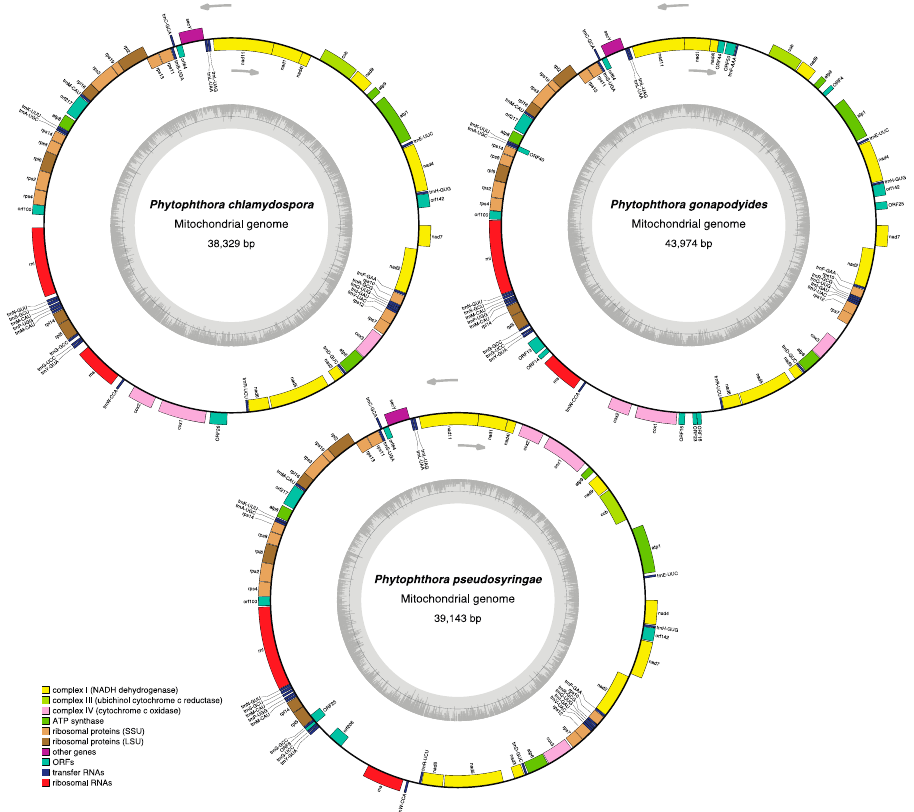
Figure 3. Circular maps of the mitochondrial genomes of Ph. chlamydospora , Ph. gonapodyides and Ph. pseudosyringae . The inner ring shows % GC content. Arrows indicate relative transcriptional orientation. The outer ring shows the predicted genes which are encoded on both strands. All three species are missing the tRNA gene for